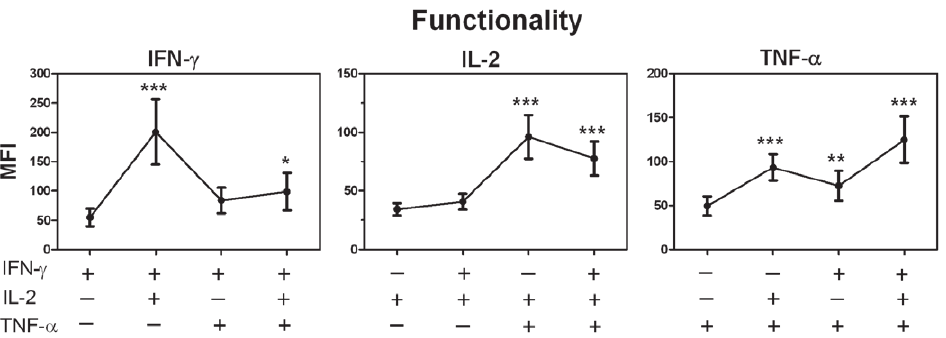
Figure 4. Multifunctional CD4 + cells demonstrate a better improved quality of effector cytokine response. PBMC from naturally M. bovis infected cattle were cultured in the presence of PPD-B and the expression of IFN- c , IL-2 and TNF- a determined by ICS flow cytometry. The Median Fluorescence Intensity (MFI) for all single, double and triple cytokine producing CD4 + cells were determined. Symbols represent the mean MFI ( 6 SEM) of each of the indicated CD4 + functional phenotypes for 10 naturally infected cattle. Significant differences between single and multifunctional phenotypes was determined by Repeat Measures ANOVA with Tukey multicomparison post-analysis test analysis (* r , 0.05, ** r , 0.01, *** r , 0.001).